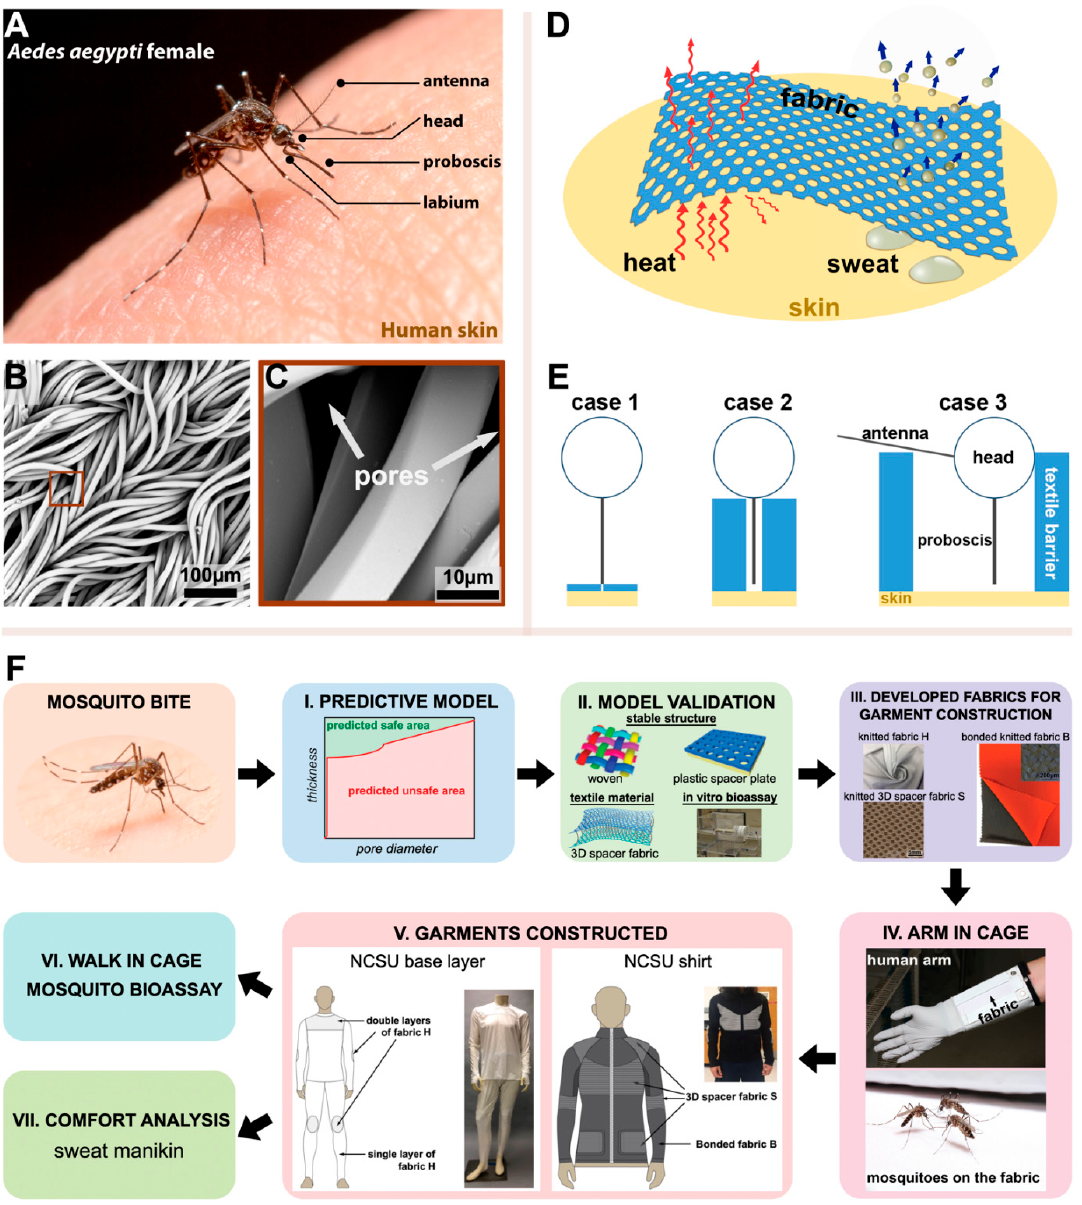
Figure 1. Principle of a bite-resistant textile structure against Aedes aegypti . ( A ) An Ae. aegypti adult female feeding on the blood beneath human skin. ( B ) SEM image of a knit structure. ( C ) Example of pores formed by the filaments in the knit structure. ( D ) Heat and moisture management of a fabric. ( E ) The proposed three cases for mosquito-bite resistance. ( F ) Research steps for the design of bite-resistant garments.